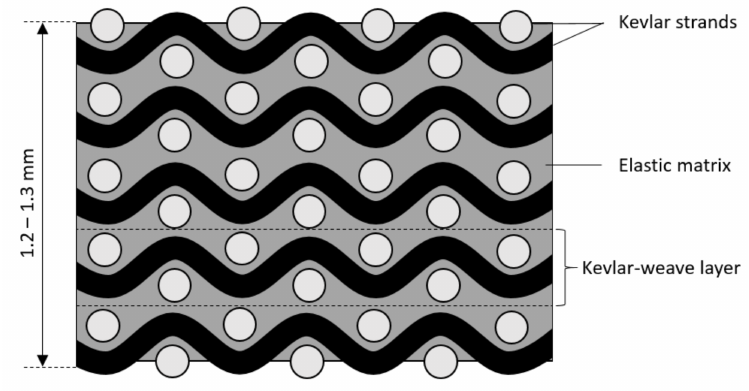
Figure 1. Schematic of the protective